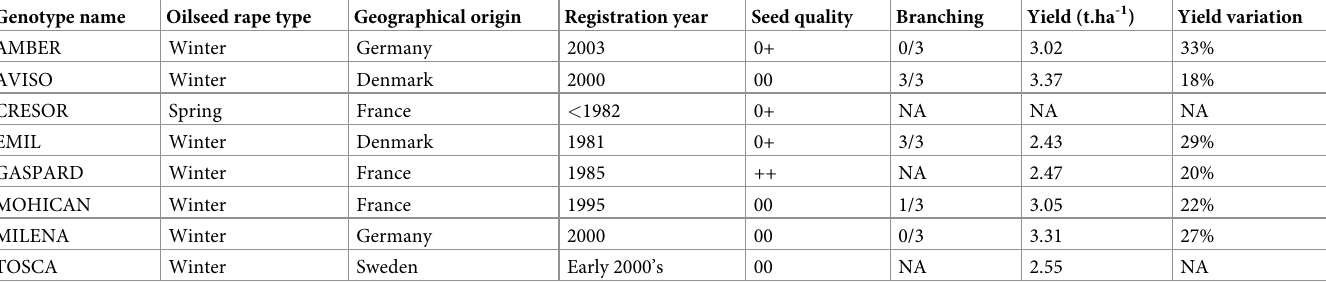
Table 1. Name and characteristics of the eight oilseed rape genotypes chosen for our